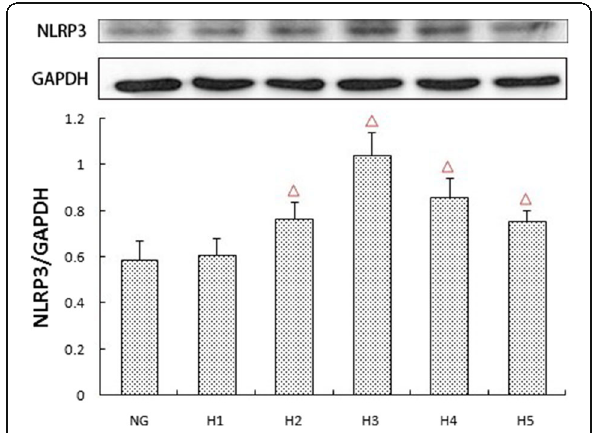
Fig. 2 Effects of different concentrations of glucose on the protein expression of NLRP3.The protein was measured by western blotting.GAPDH was used as an internal loading control. NG:normal control group,H1:glucose concentration of 15 mmol/L,H2:glucose concentration of 25 mmol/L,H3:glucose concentration of 30